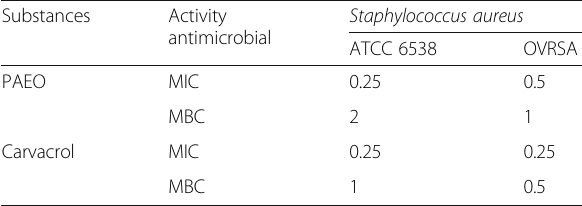
Table 3 Distribution of the Staphylococcus aureus strains according to inhibition zone size against the essential oil Plectranhus amboinicus , carvacrol and tetracycline Inhibition halos Shrimp ( n = interval (mm)